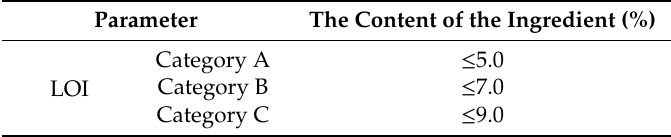
Table 7. Requirements for the chemical composition of the waste [32]. Parameter